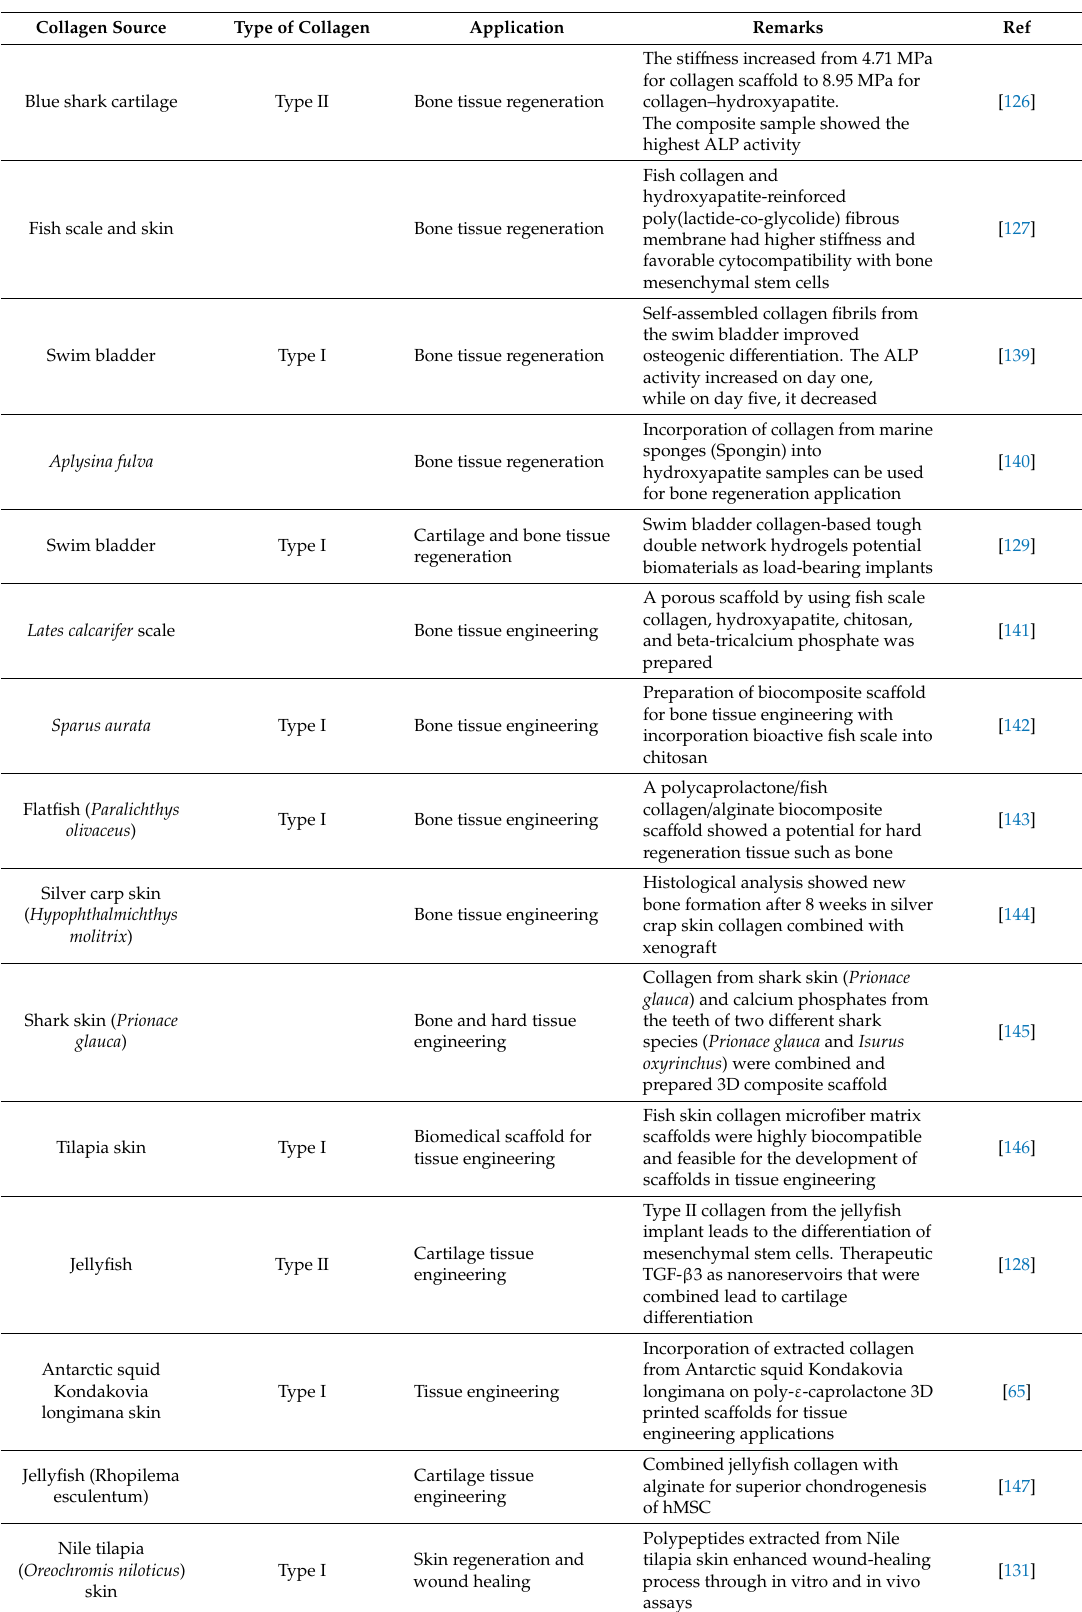
Table 7. A summary of fish collagen applications for biomaterials